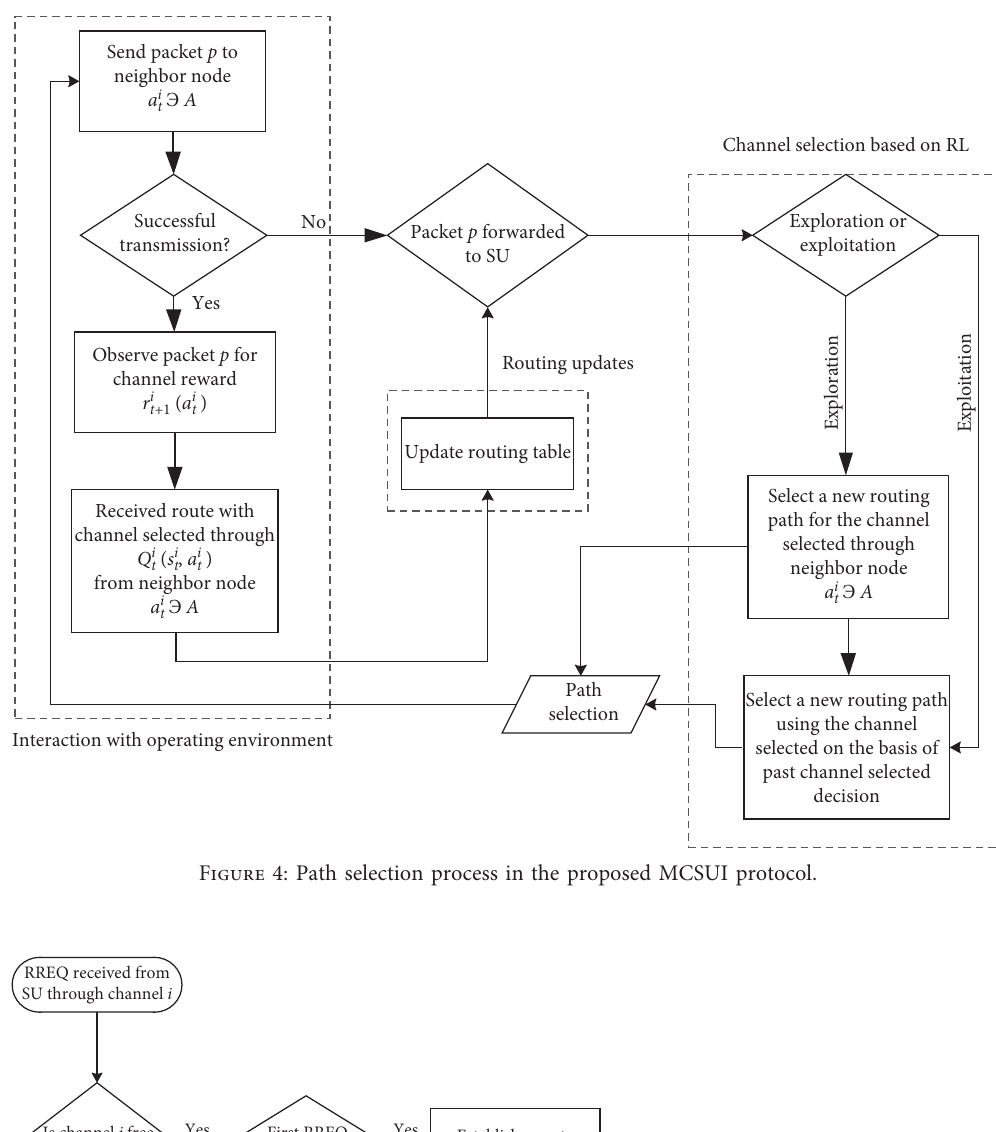
Figure 4: Path selection process in the proposed MCSUI protocol.